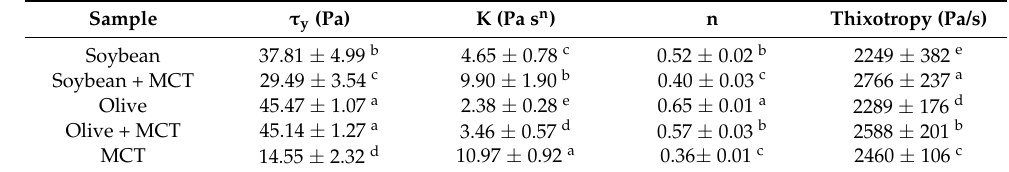
Figure 3. Effect of frequency on the tan(delta) of the mayonnaise samples.